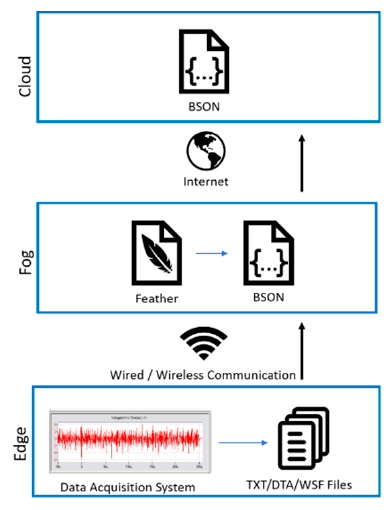
Figure 2. Data Architecture in the developed IIoT system.